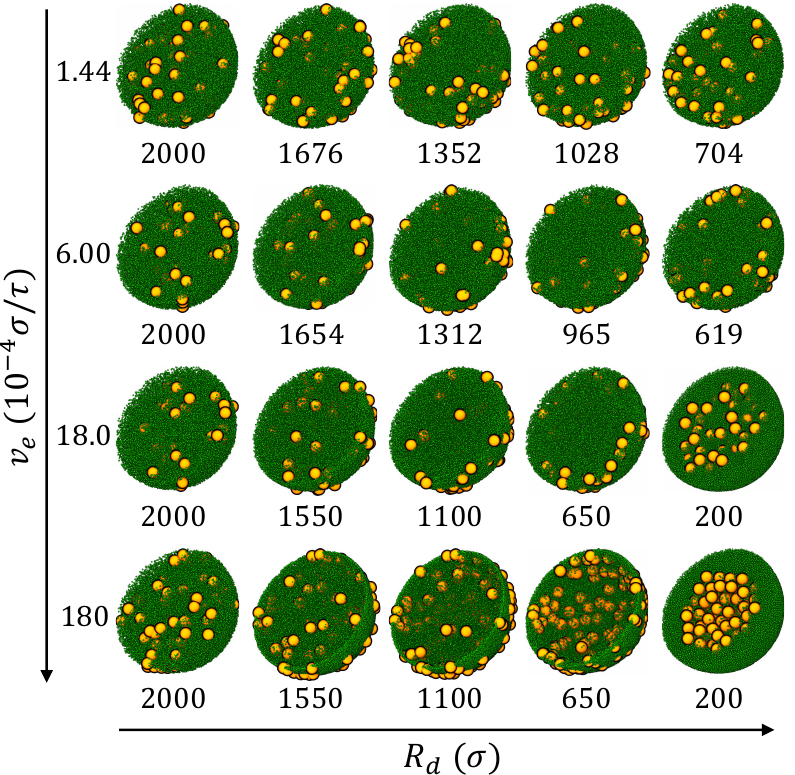
Figure 3. Snapshots of drying droplets of bidisperse mixtures of LNPs (orange) and SNPs (green) at various evaporation rates ( v e ). The droplet radius ( R d ) is indicated below each snapshot. All the droplets are sliced through the center to show the interior and scaled to the same size to improve